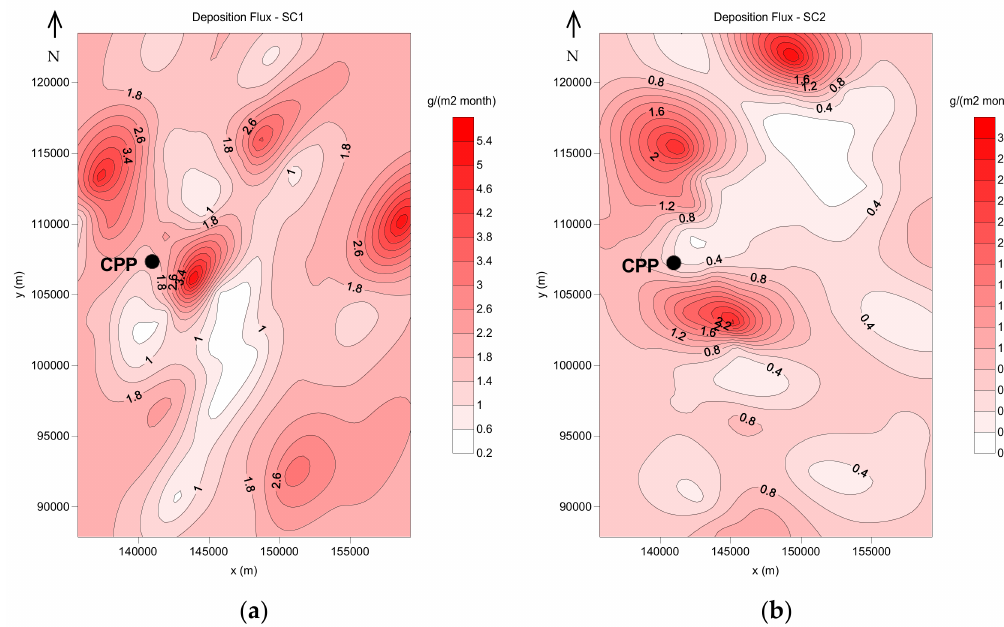
Figure 7. Spatial variability of the flux deposition, in g m − 2 per month: ( a ) SC1 and ( b )